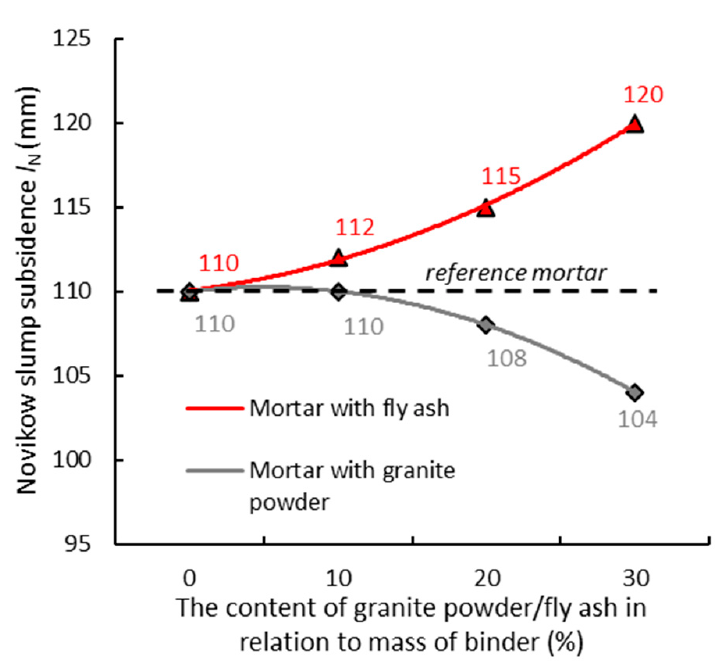
Figure 8. Test results of the Novikov cone subsidence ( l N ) for the mortars, which differ regarding their content of granite powder/fly ash in relation to the mass of the cement.